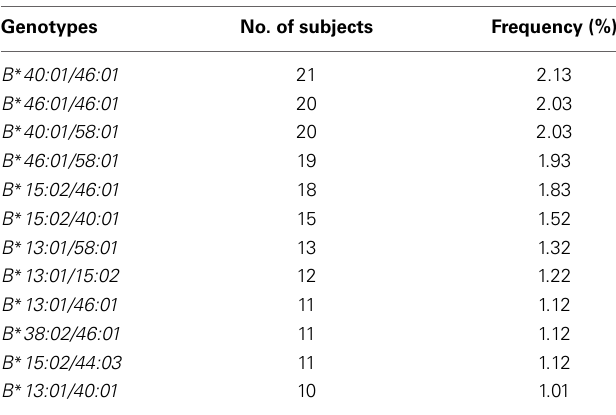
Table 2 | Top 10 common genotypes in the Thais (n =